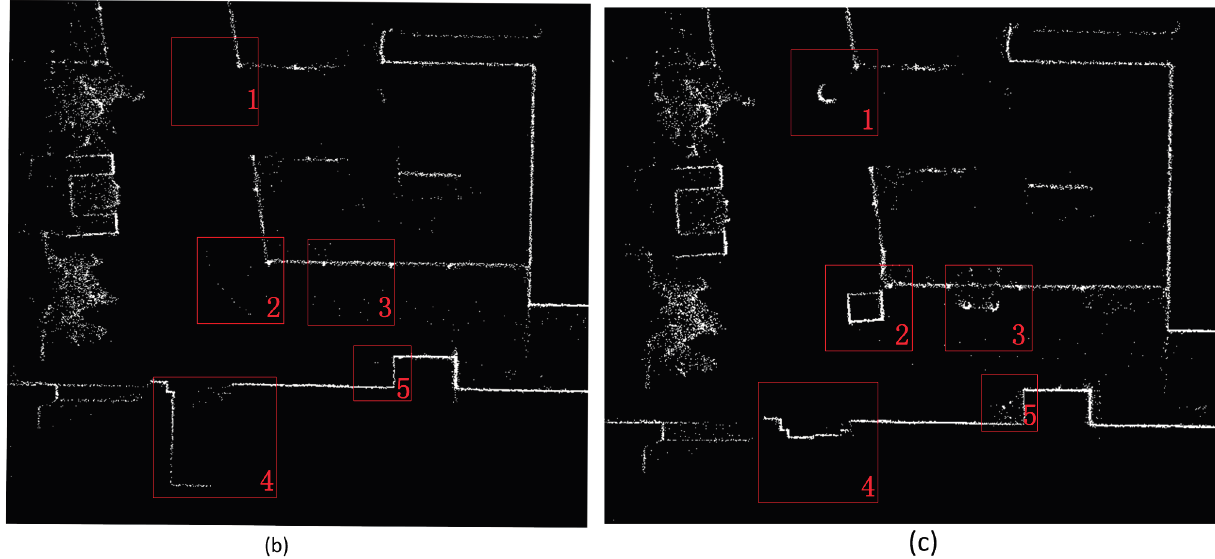
Figure 11. ( a ) Real objects in the corridor; ( b ) Grid map of corridor turn without obstacles; ( c ) Grid map of corridor turn with obstacles.